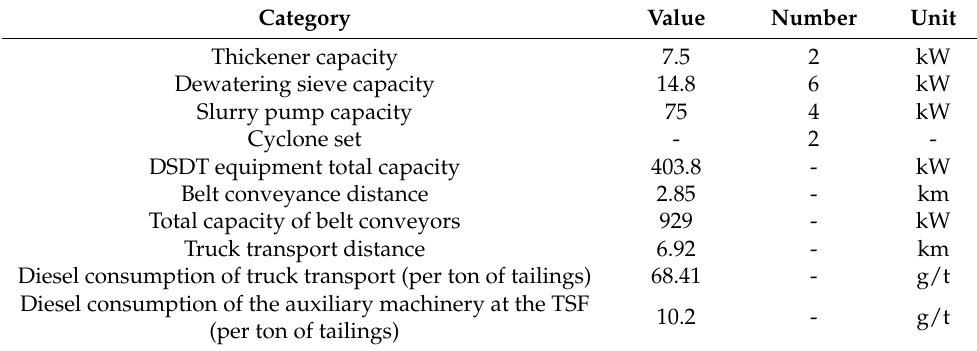
Table 2. DSDT scheme LCA